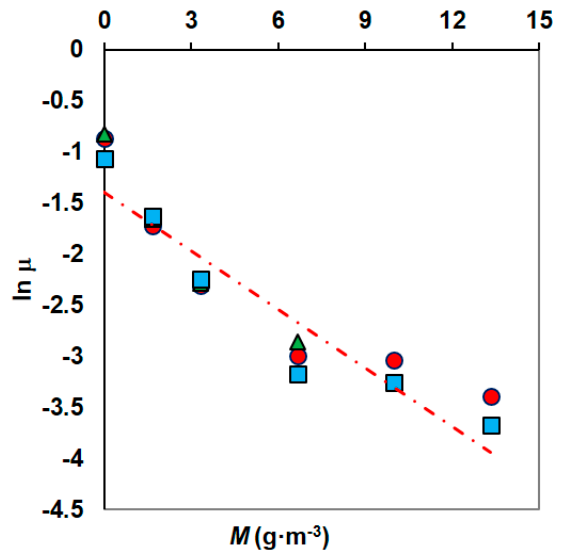
Figure 5. The method of determining the parameters of the Kai model (phenol concentrations: 100 g·m − 3 ( ● ), 150 g·m − 3 ( ▲ ), 300 g·m − 3 ( ■